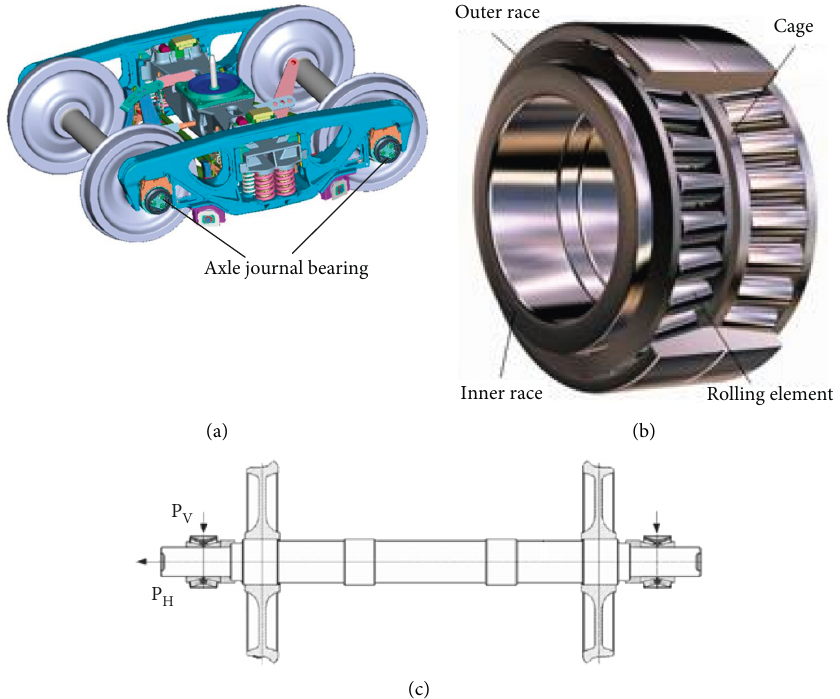
Figure 2: Structure of axle journal bearing for railway freight wagon. (a) Car bogie of railway freight. (b) Double-row tapered roller bearing. (c) Force analysis of axle journal bearing.